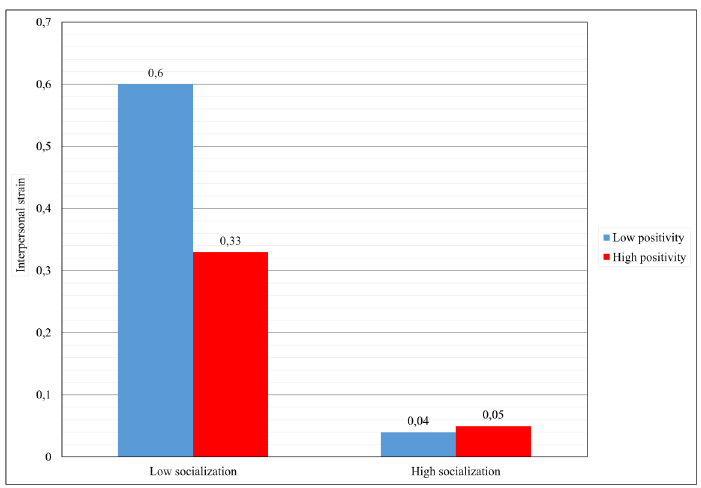
Fig 3. Simple slope analysis of the interaction between positivity and organizational socialization on interpersonal strain.